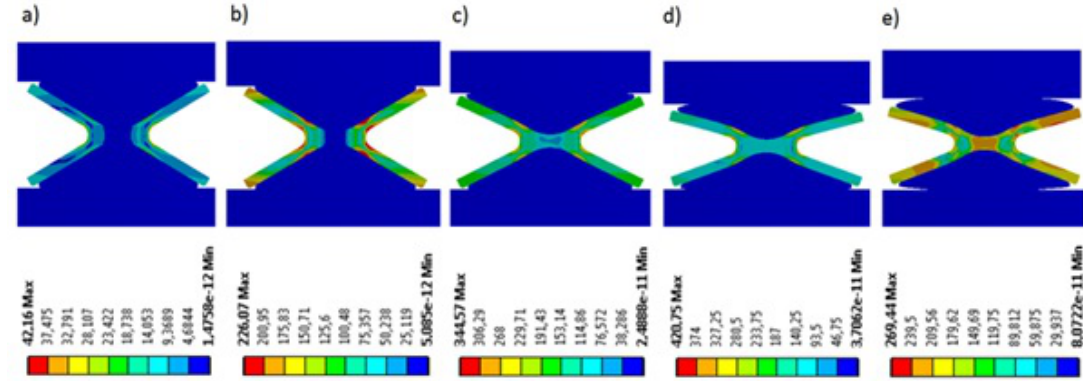
Figure 8: Equivalent stress distribution in MPa of gasket model No. 180: a) compression 0.3 mm, b) compression 0.5 mm, c) compression